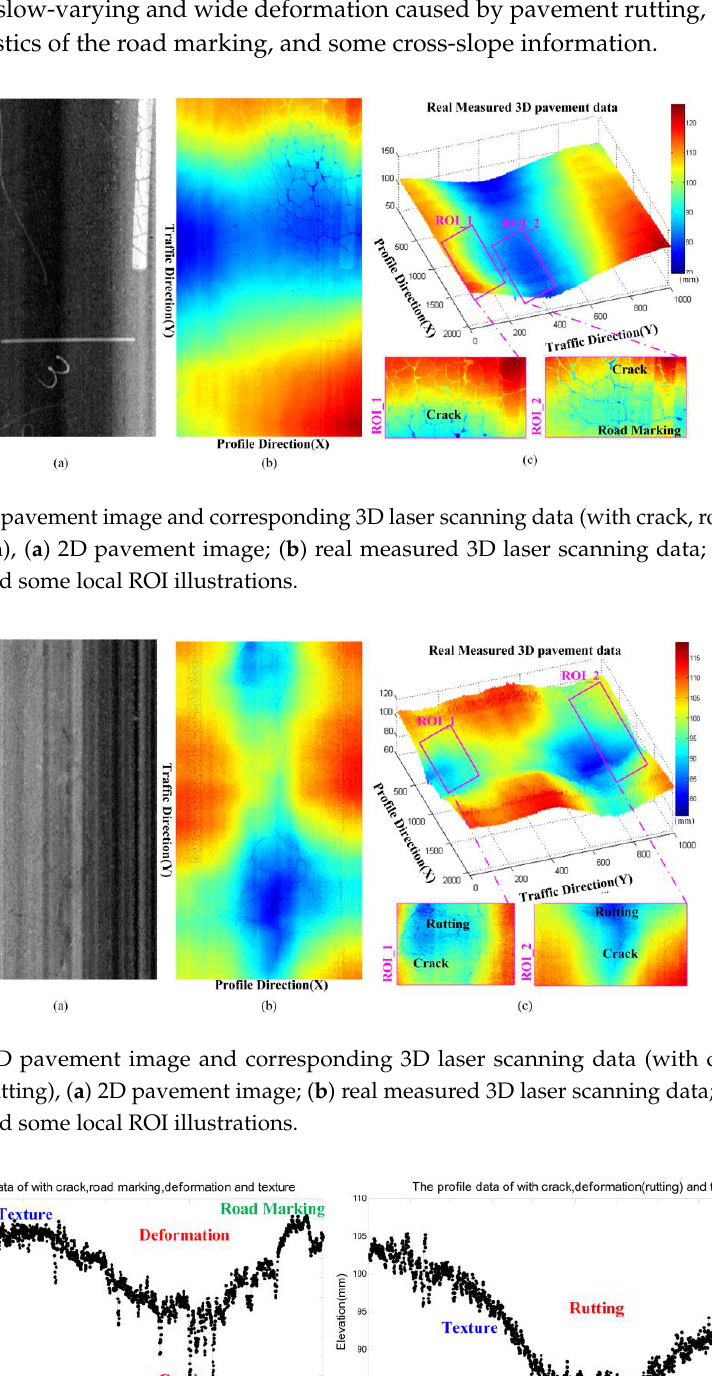
Figure 4. The pavement profile data with different information, ( a ) the profile with cracks, road markings, deformation, and texture; and ( b ) profile with cracks, rutting, and texture.